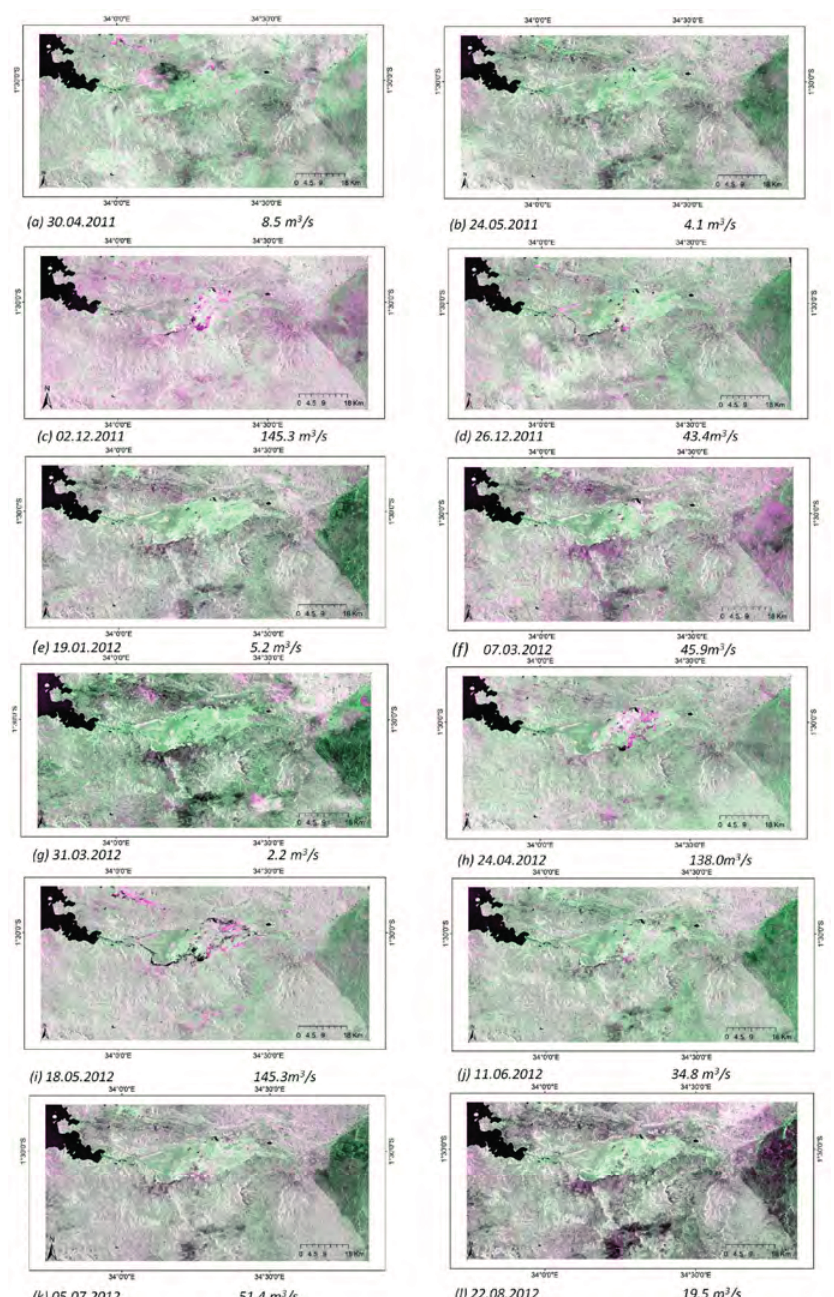
Figure 6. Sub figures a – l above shows RGB color composite images for 12 Radarsat-2 SAR images acquired over the Lower Mara Basin. Image aquisation dates and average daily river discharge values are shown in the bottom of each image. RGB color composite imageries are attributting to VV, VH and VV polarization for Red, Green and Blue channels